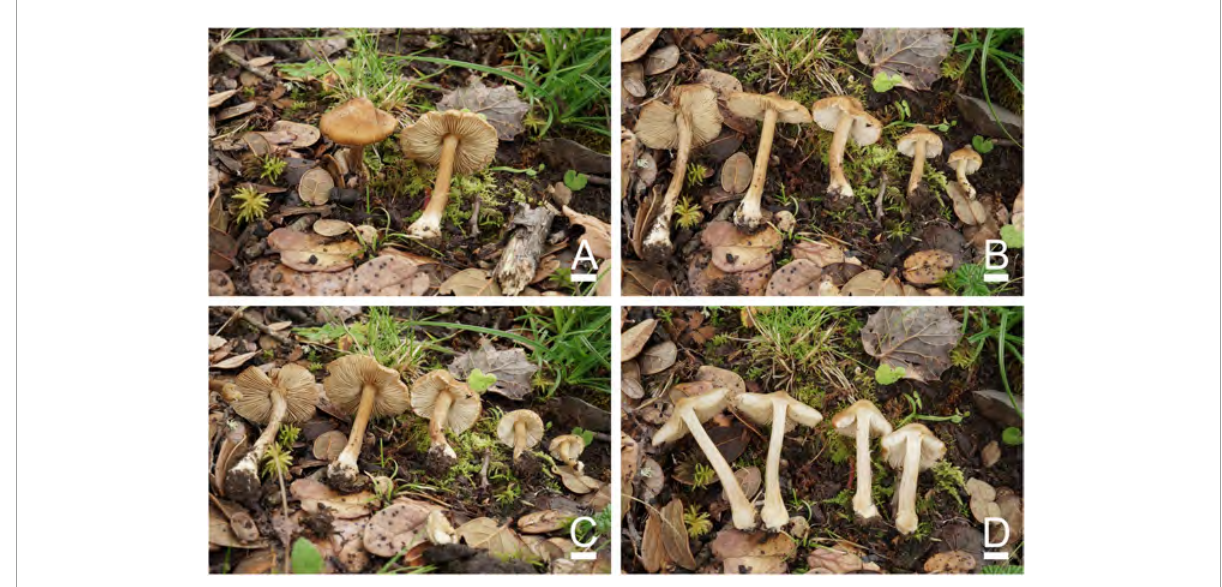
FIGURE4 Basidiomata of Inosperma sphaerobulbosum . (A–D) MHHNU32266, holotype. Scale bars = 10 mm.